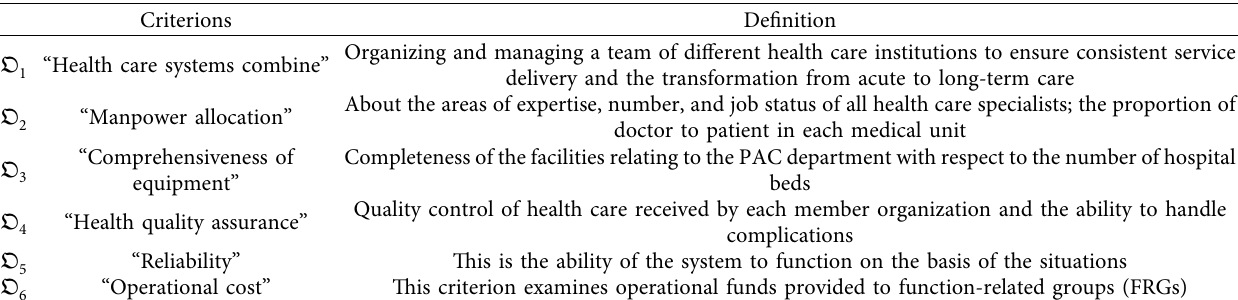
Figure 4: Death rate chart per 100,000 population. Table 3: Requirements for selecting the appropriate option in the